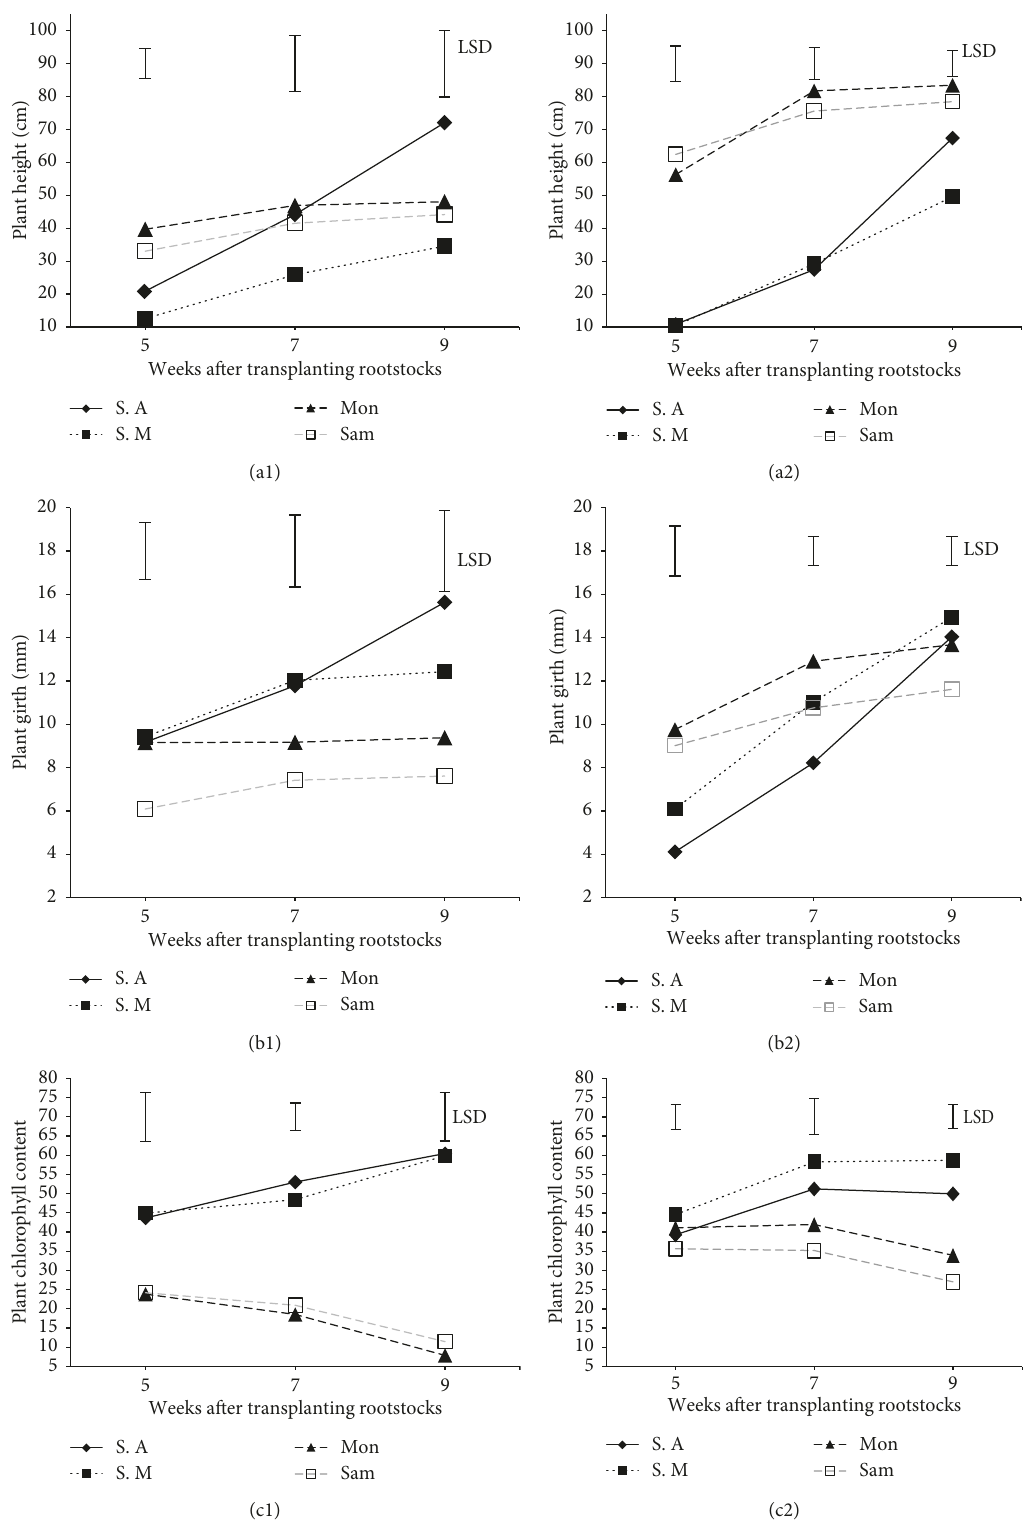
Figure 1: Growth parameters of rootstocks to RKN infection at five, seven, and nine weeks after transplanting rootstocks. (a) The mean plant height, (b) the mean plant girth (c) the mean chlorophyll content in 2015 (1) and 2016 (2). Rootstocks: Sam � Samrudhi F1; Mon � Mongal F1; S. M � S. macrocarpon ; S. A � S. aethiopicum . Data were analyzed with two-way ANOVA and significant means separated with the least significant difference (LSD) test. LSD bars represent the least significant difference at P ≤ 0 .